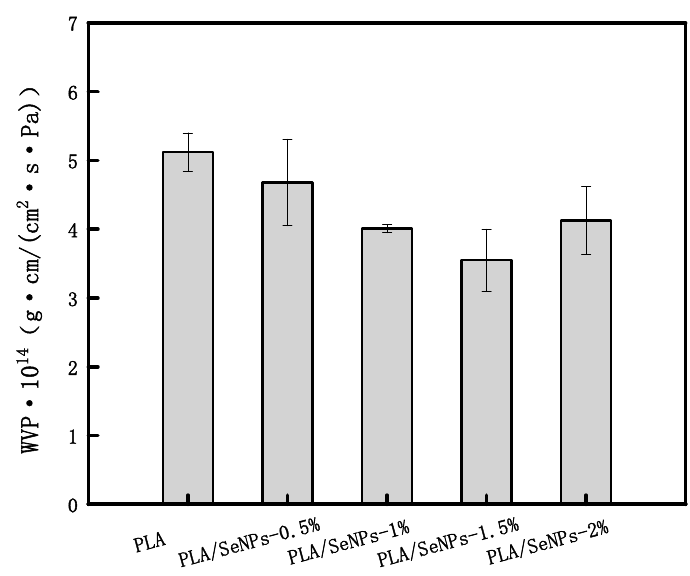
Figure 5. Water vapor permeability of different composite films. ( p < 0.05).